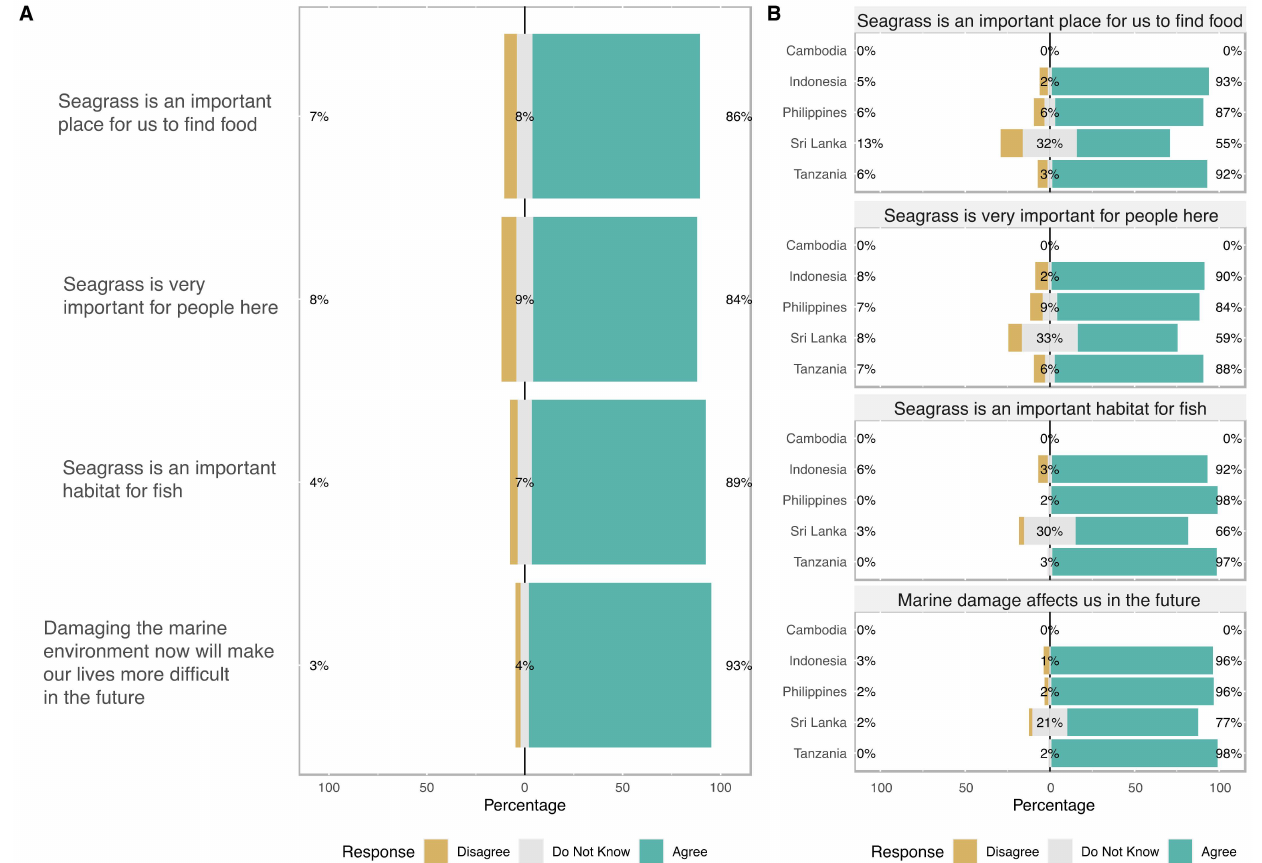
Figure 2. Consensus statements related to seagrass importance for food and fisheries in the Indo- Pacific region: ( A ) across the whole dataset; ( B ) across each country. Respondents were